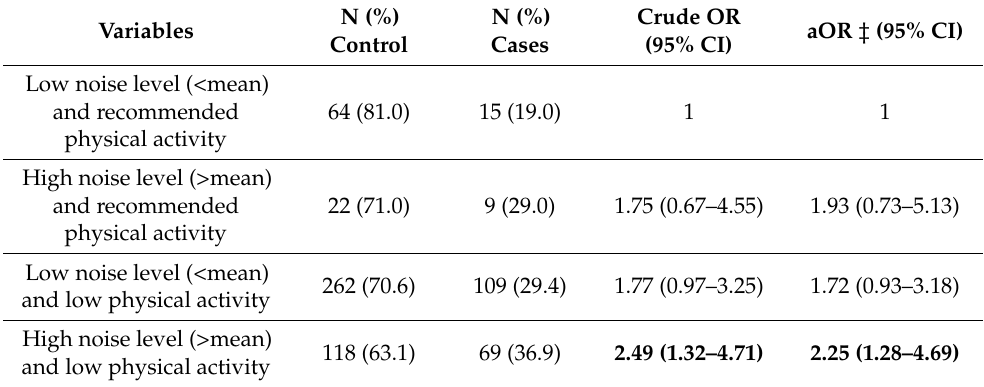
Table 5. Multivariable logistic regression relationships between noise level, physical activity, and the risk of hypertension in 45–64-year-old